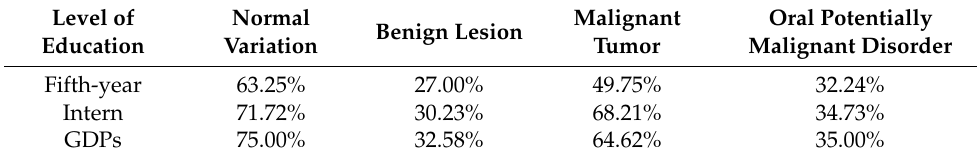
Table 2. Percentage of correct answers per category according to education